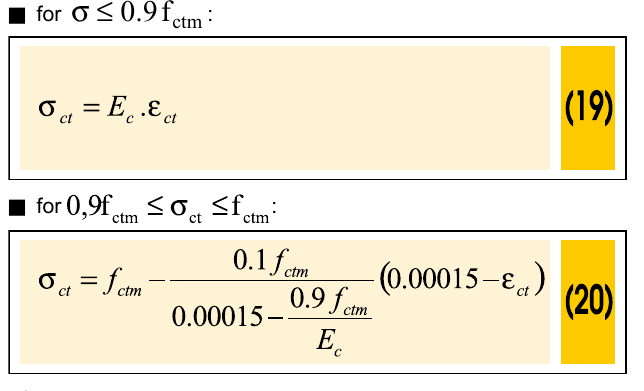
• J , J : the second and the third invariant of deviatoric stress tensor. 2 3 The concrete stress-strain behavior of concrete subjected to ten - sile stresses should be expressed by two relations: a stress-strain relationship representing the behavior of the concrete outside the fracture zone and a stress-crack opening relation which describes the deformations occurring within the fracture zone. The CEB-FIP Model Code 1990 (1993) presents a stress-crack opening relation for cracked concrete, σ-w, as shown in figure 4. To represent the uncracked concrete behavior, subjected to tensile stresses, the CEB-FIP Model Code 1990 (1993) suggests a bilin - ear stress-strain relationship, as given in equations 19 and 20: